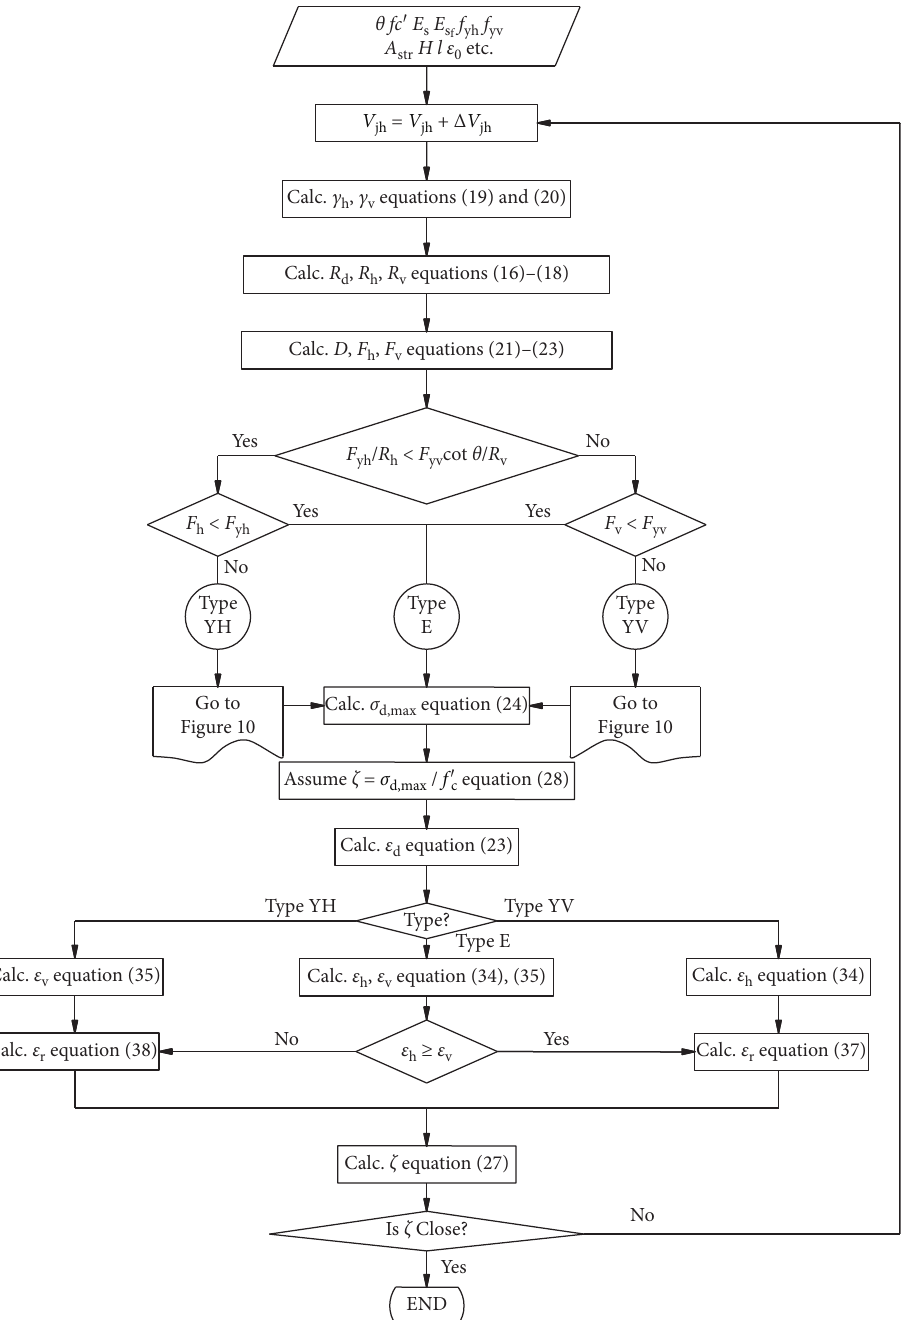
Figure 9: Flow chart showing efficient